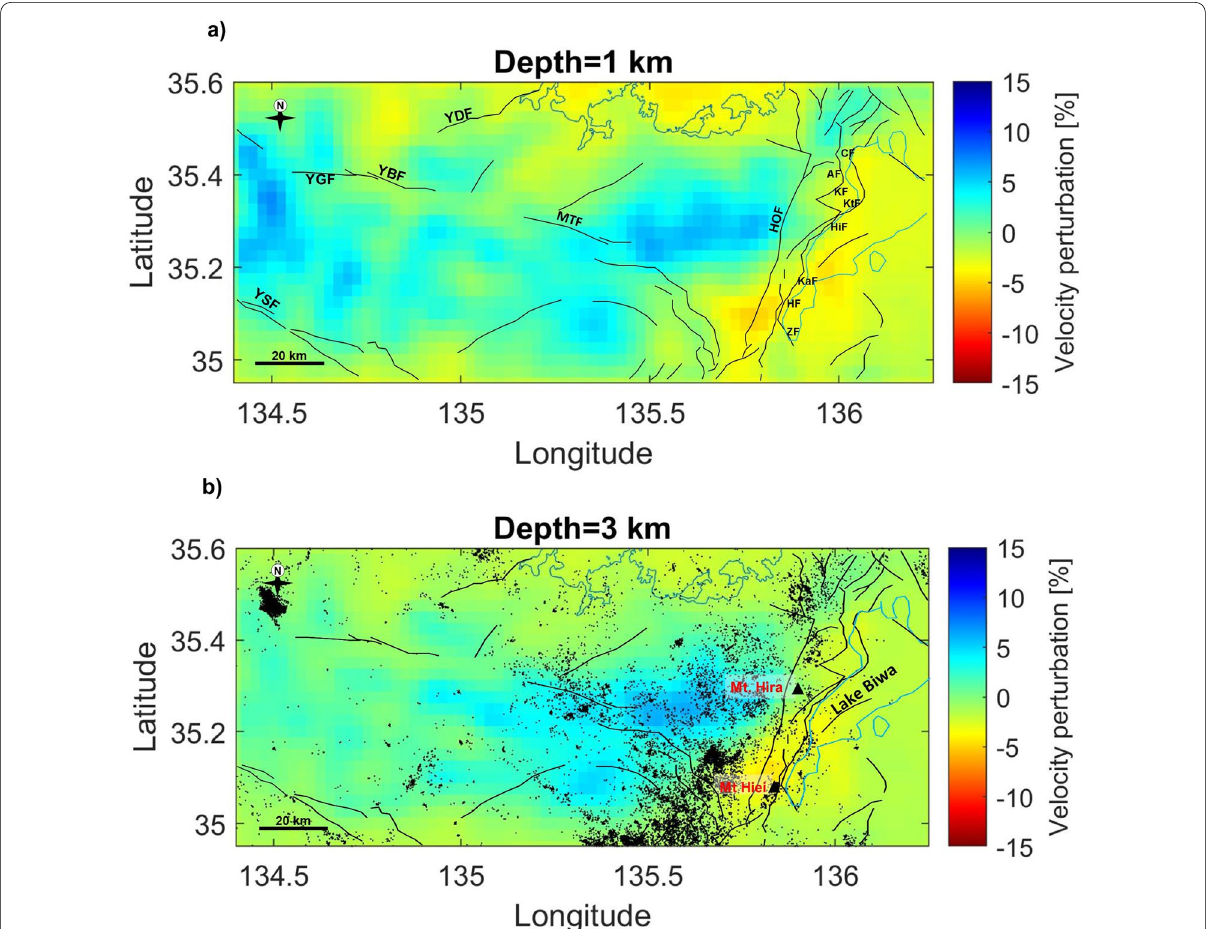
Fig. 11 a Enlarged view of the northern part of the Kinki region (shown in Fig. 9) showing the perturbation of S-wave velocity at a depth of 1 km below sea level. Also shown are the locations of the Yamada Fault (YDF), Yamasaki Fault (YSF), Yagi-Yabu Fault (YGF-YBF), Mitoke Fault (MTF), Hanaore Fault (HOF) and the Biwako-seigan Fault Zone members (Chinai Fault, CF; Aibano Fault, AF; Kamidera Fault, KF; Katsuno Fault, KtF; Hira Fault, HiF; Katata Fault, KaF; Hiei Fault, HF; Zeze Fault, ZF) (Kaneda et al. 2008). b perturbation of S-wave velocity at a depth of 3 km below sea level, overlaid with earthquake hypocenters (black dots; Yano et al. 2017) and active faults. Black triangles represent the Hira and Hiei mountains. Solid black lines show the location of documented active faults (Research Group for Active Faults of Japan